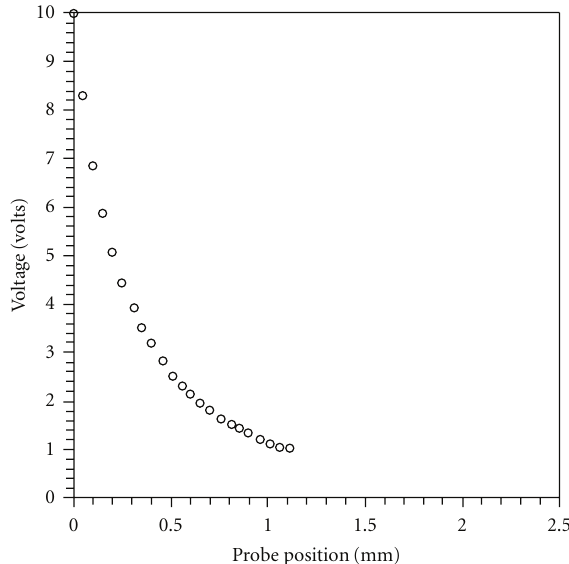
Figure 13: FM capacitance probe output plotted against known clearance after compensating for shaft eccentricity.